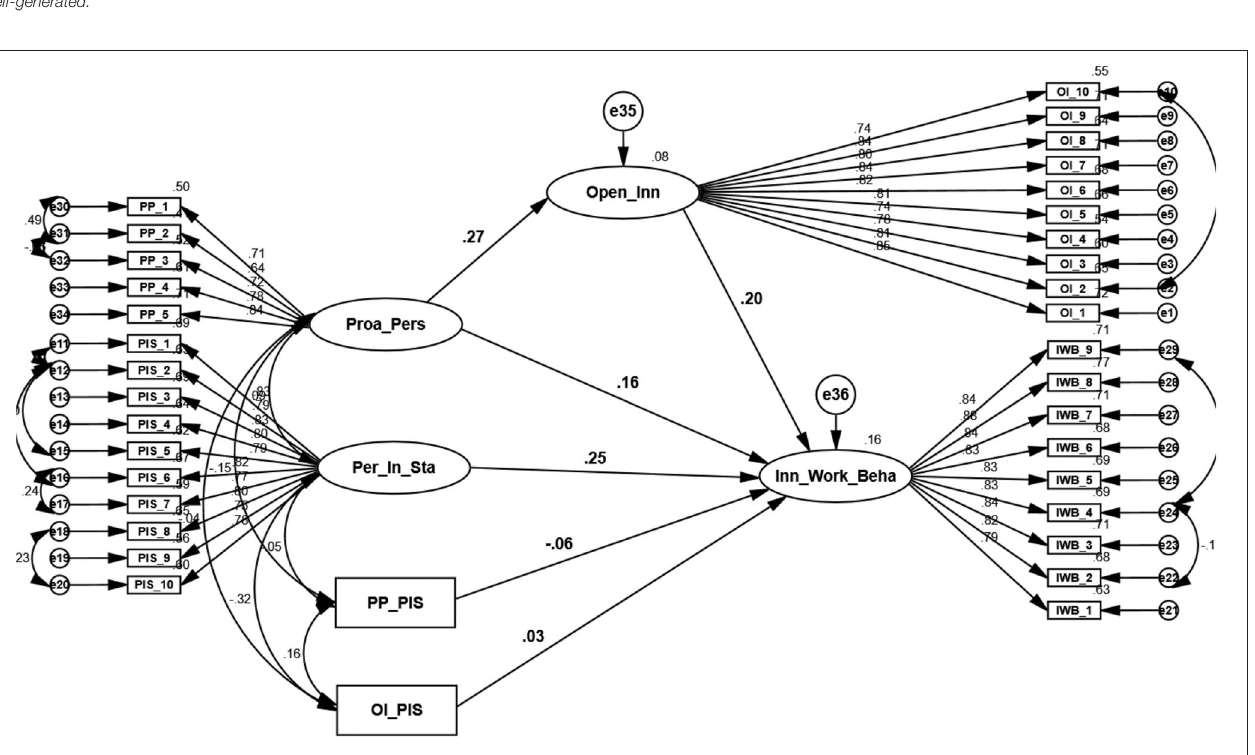
endogenous. The moderation effect of PIS on OI and IWB was